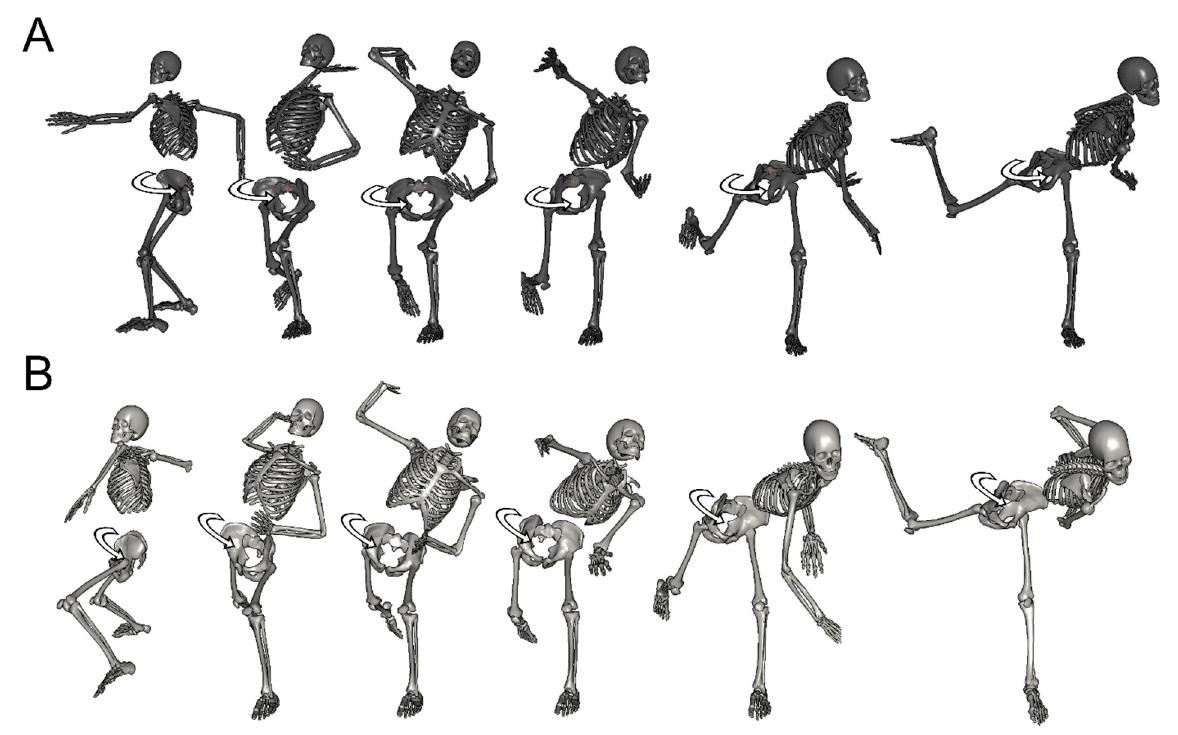
Figure 4. The pitching form of the representative example watched from home base. ( A ): Women/horizontal rotational movement, ( B ): men/oblique rotational movement.